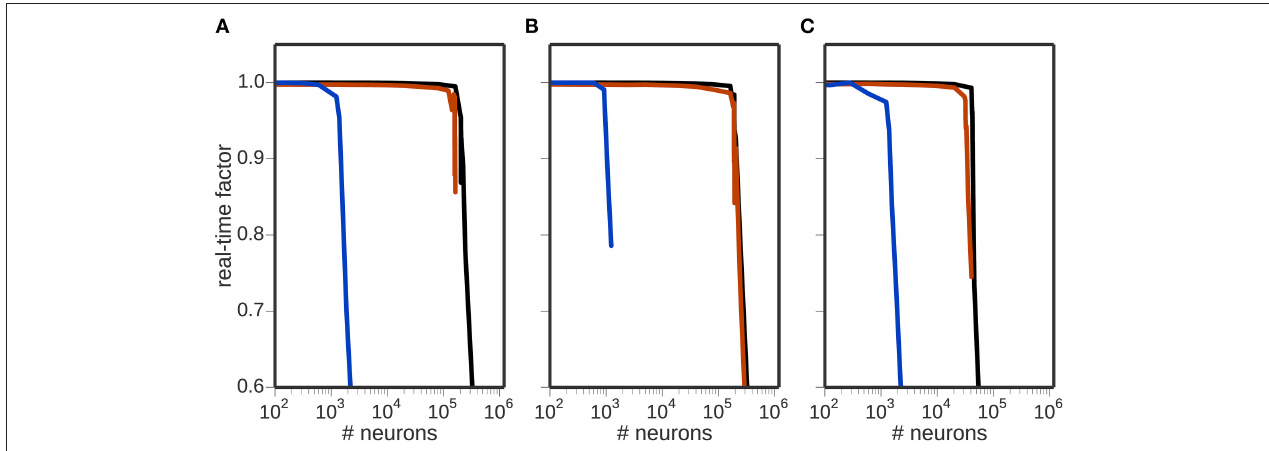
FIGURE 2 | Scalability of the toolchain. Real-time factor as a function of the number of neurons used for encoding using different encoders: (A) rate encoding mechanism; (B) Poissonian encoding mechanism; (C) NEF encoding mechanism. In each panel, the black curve shows the real-time performance in the absence of a neuronal simulator, the red curve shows the performance using NEST and the blue curve the performance using NEURON.